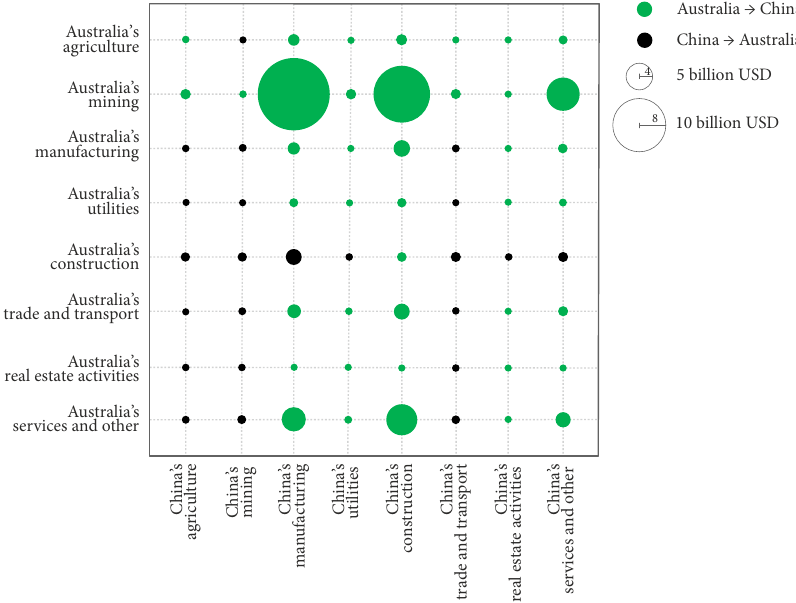
Figure 5. Net value added in inter-industrial trade between Australia and China in